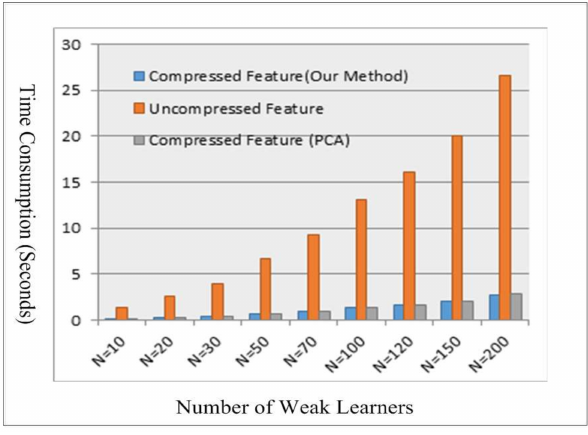
Figure 13. Time consumption of three kinds of